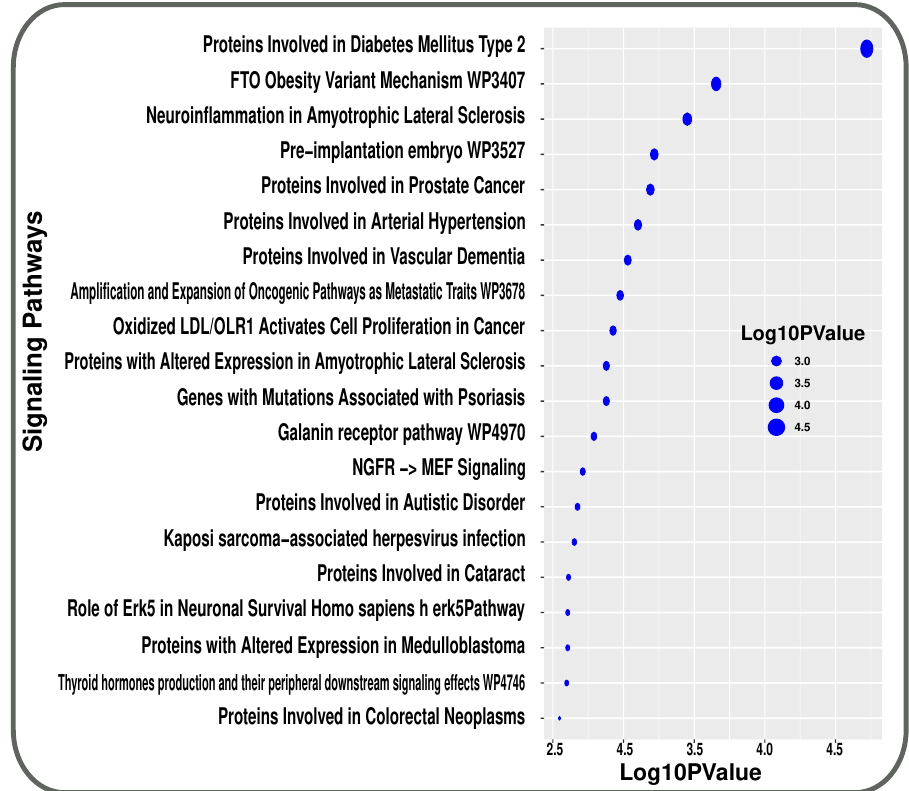
Figure 13. Top 20 pathways are represented using a bubble plot that are associated with both conditions in GWAS